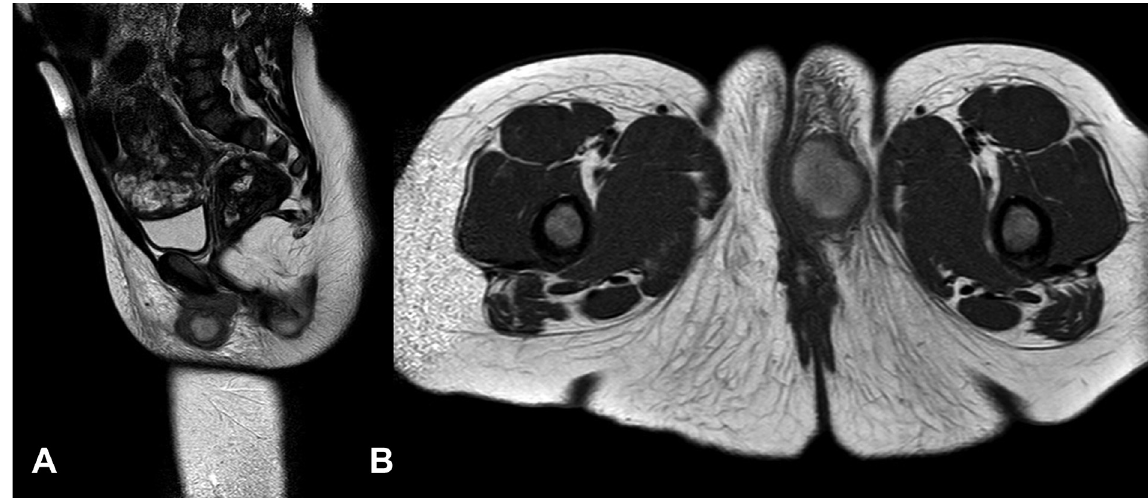
Fig. 3 Sagittal ( A ) and axial ( B ) sections, T2-weighted magnetic resonance imaging showing a hyperintense rounded mass, encapsulated with a necrotic central component and ring enhancement. European Journal of Pediatric Surgery Reports Vol. 10 No. 1/2022 © 2022. The